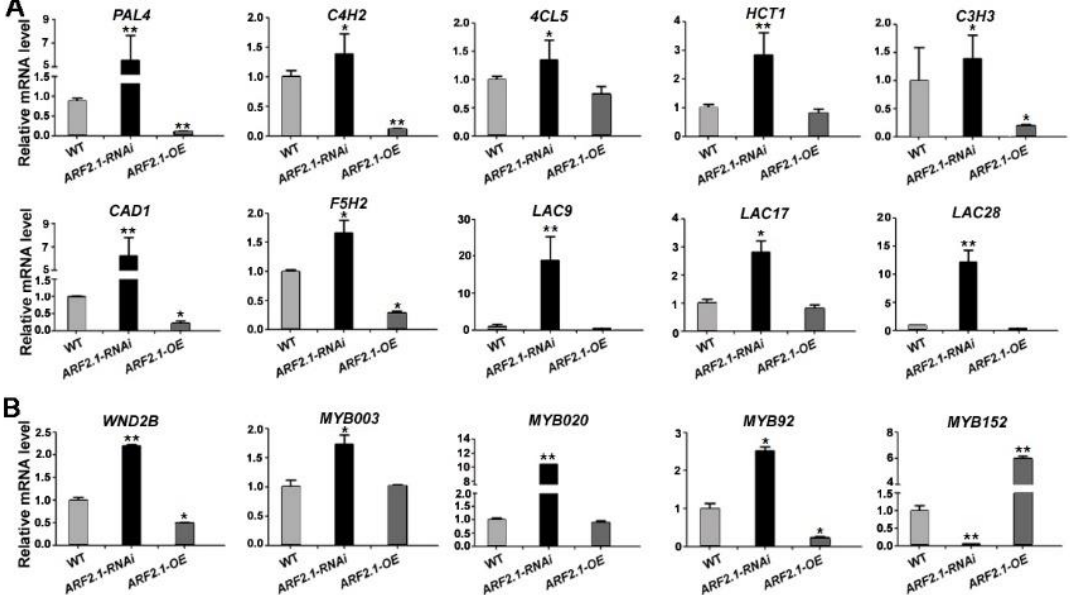
Figure 7. Relative expression levels of genes associated with the lignin biosynthesis in PtrARF2.1-RNAi and PtrARF2.1 -OEpoplars. ( A ) Analysis of the expression levels of genes involved in the phenylpropanoid/monolignol biosynthetic pathway by qRT-PCR methods. ( B ) Analysis of the expression levels of the lignin-associated with TF genes by qRT-PCR methods. Total RNA was extracted from the WT, PtrARF2.1-RNAi and PtrARF2.1 -OE leaves. The poplar 18S rRNA was used as an internal control. Error bars mean ±SD of three biological replicates. Stars indicate the statistical significance using Student’s t -test: * p -value < 0.05, ** p -value < 0.01.